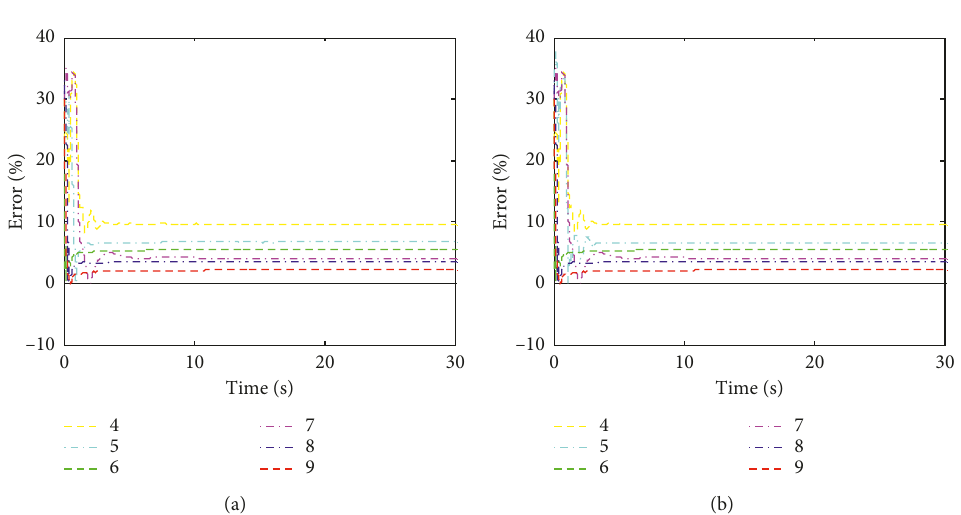
Figure 9: Estimated stiffness coefficients for different numbers of measurements on the (a) fifth floor and (b) tenth